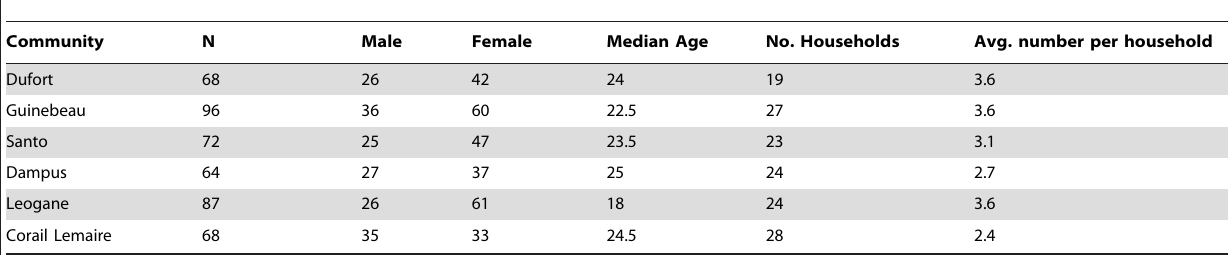
Table 1. Community characteristics of tested